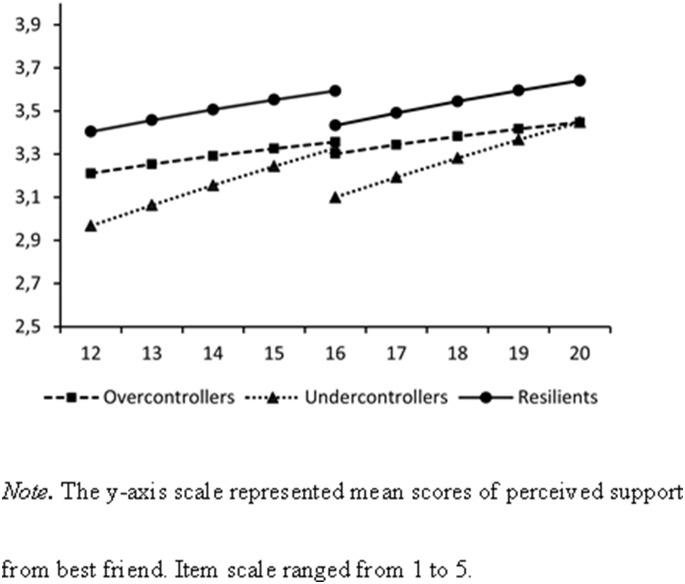
Estimated Developmental Changes in Adolescent Friendship Support by Adolescent Personality Types.